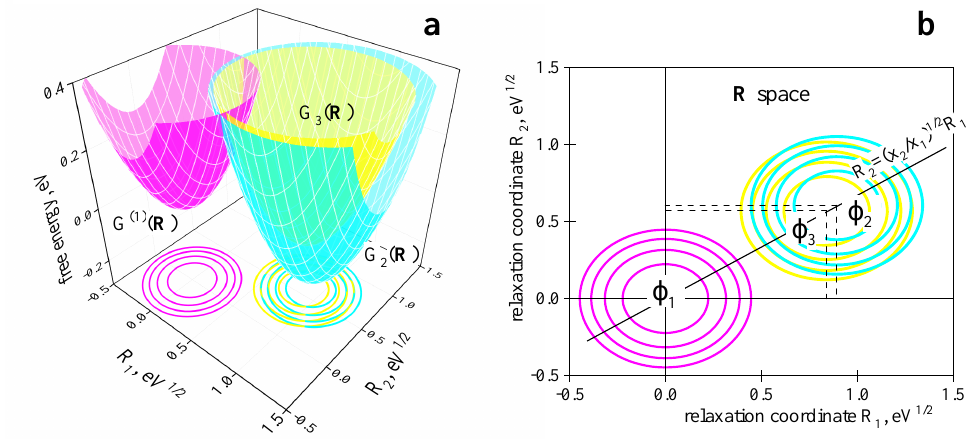
Figure 4. ( a ) Free energy surfaces of the ET states as functions of the relaxation coordinates R 1 and R 2 . The surfaces are calculated by orthogonal projection from the q space onto the . The x 1 and x 2 parameters correspond to acetonitrile (given in the text), other parameters are the same as in Figure 3. ( b ) Arrangement of the FESs minima on the ( R 1 , R 2 ) plane: the ˇR ( n ) points are located on the straight √ x 2 / x 1 line given by the equation R 2 / R 1 =